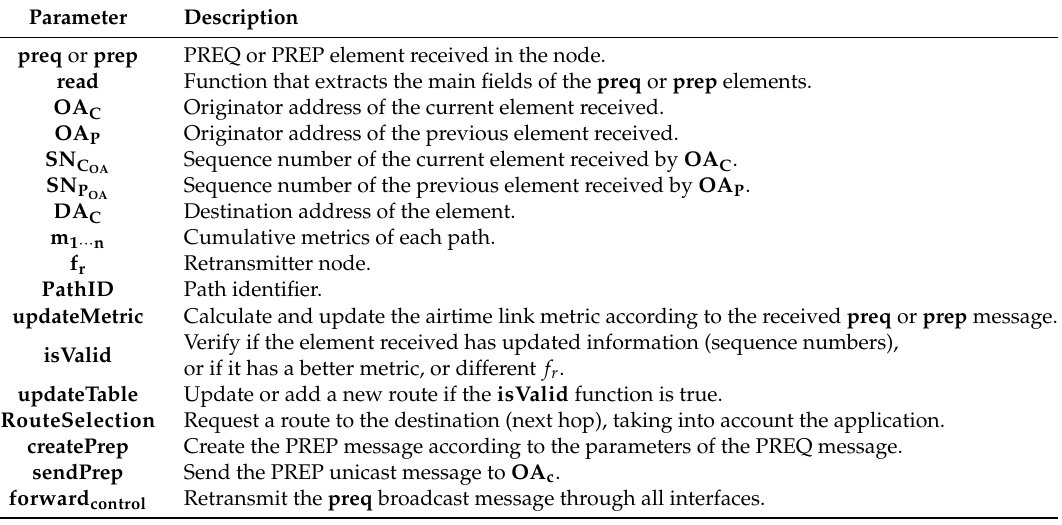
Table 1. Definition of the variables and functions for the PREQ and PREP mechanisms.